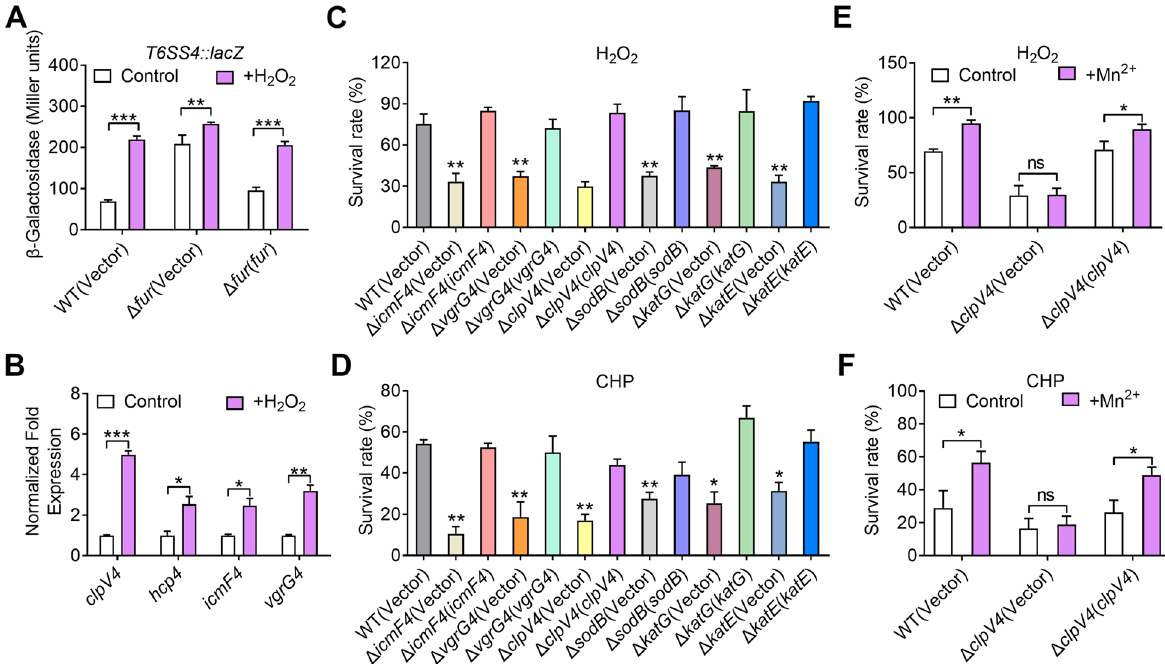
Fig. 4 Fur-regulated T6SS4 combats oxidative stress by importing Mn 2 + . A The negative regulation of T6SS4 by Fur was derepressed by H 2 O 2 challenge. β-galactosidase analyses of T6SS4 promoter activities in Y. pseudotuberculosis strains grown to stationary phase in YLB medium with or without 5 mM H 2 O 2 . B T6SS4 expression responds to oxidative stress. Y. pseudotuberculosis WT was grown in M9G medium with or without 5 mM H 2 O 2 , and the expression of clpV4 , hcp4 , icmF4 , and vgrG4 was measured by qRT-PCR. C‑D T6SS4 is involved in oxidative stress resistance. The viability of mid-exponential phase Y. pseudotuberculosis strains was determined after exposure to 1 mM H 2 O 2 or 0.5 mM CHP for 40 min in M9G medium. E‑F The alleviation of the sensitivity of Y. pseudotuberculosis strains to oxidative stress by exogenous Mn 2 + required T6SS4. Relevant mid-exponential phase bacterial strains were exposed to 1 mM H 2 O 2 or 0.5 mM CHP in M9G medium with or without exogenously provided Mn 2 + (1 μM) for 40 min and the viability of the cells was determined. Data represent the mean SEM of three biological replicates, each of which was ± performed with three technical replicates. * P < 0.05; ** P < 0.01; *** P < 0.001; ns, not